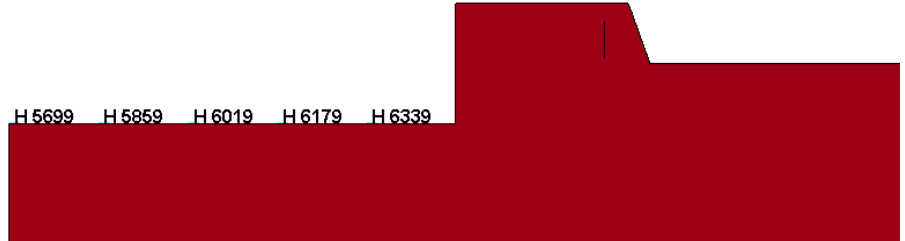
Figure 14. Layout of the horizontal radial monitoring point is located at an elevation of 20 m.